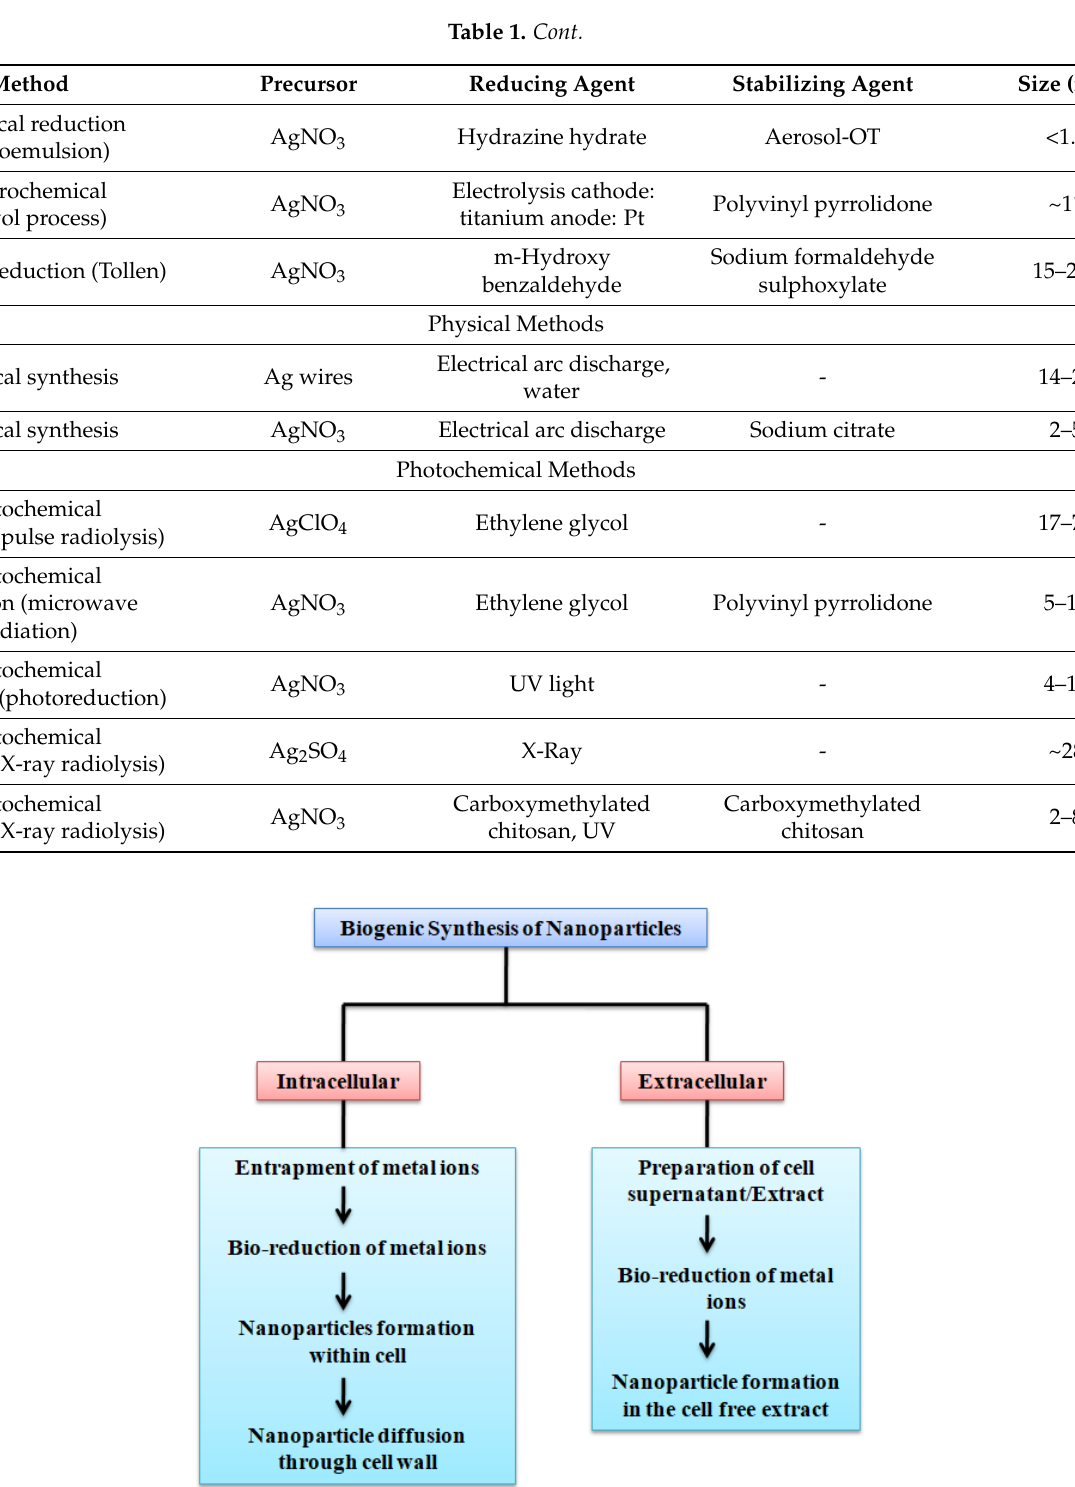
Figure 2. Methods of biosynthesis of metal nanoparticles.